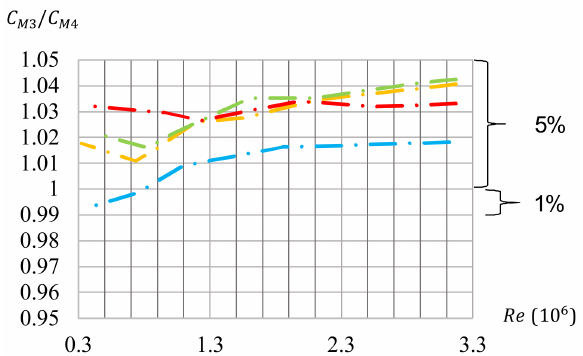
Figure 15. Results of C m 3 / C m 4 at the distinguishing lines. C M 3 : C M for regime III; C M 4 : C M for regime IV. Colors: Blue: C D (cid:48) = 1262, Yellow: C D (cid:48) = 2525, Green: C D (cid:48) = 3787; Red: C D (cid:48) =